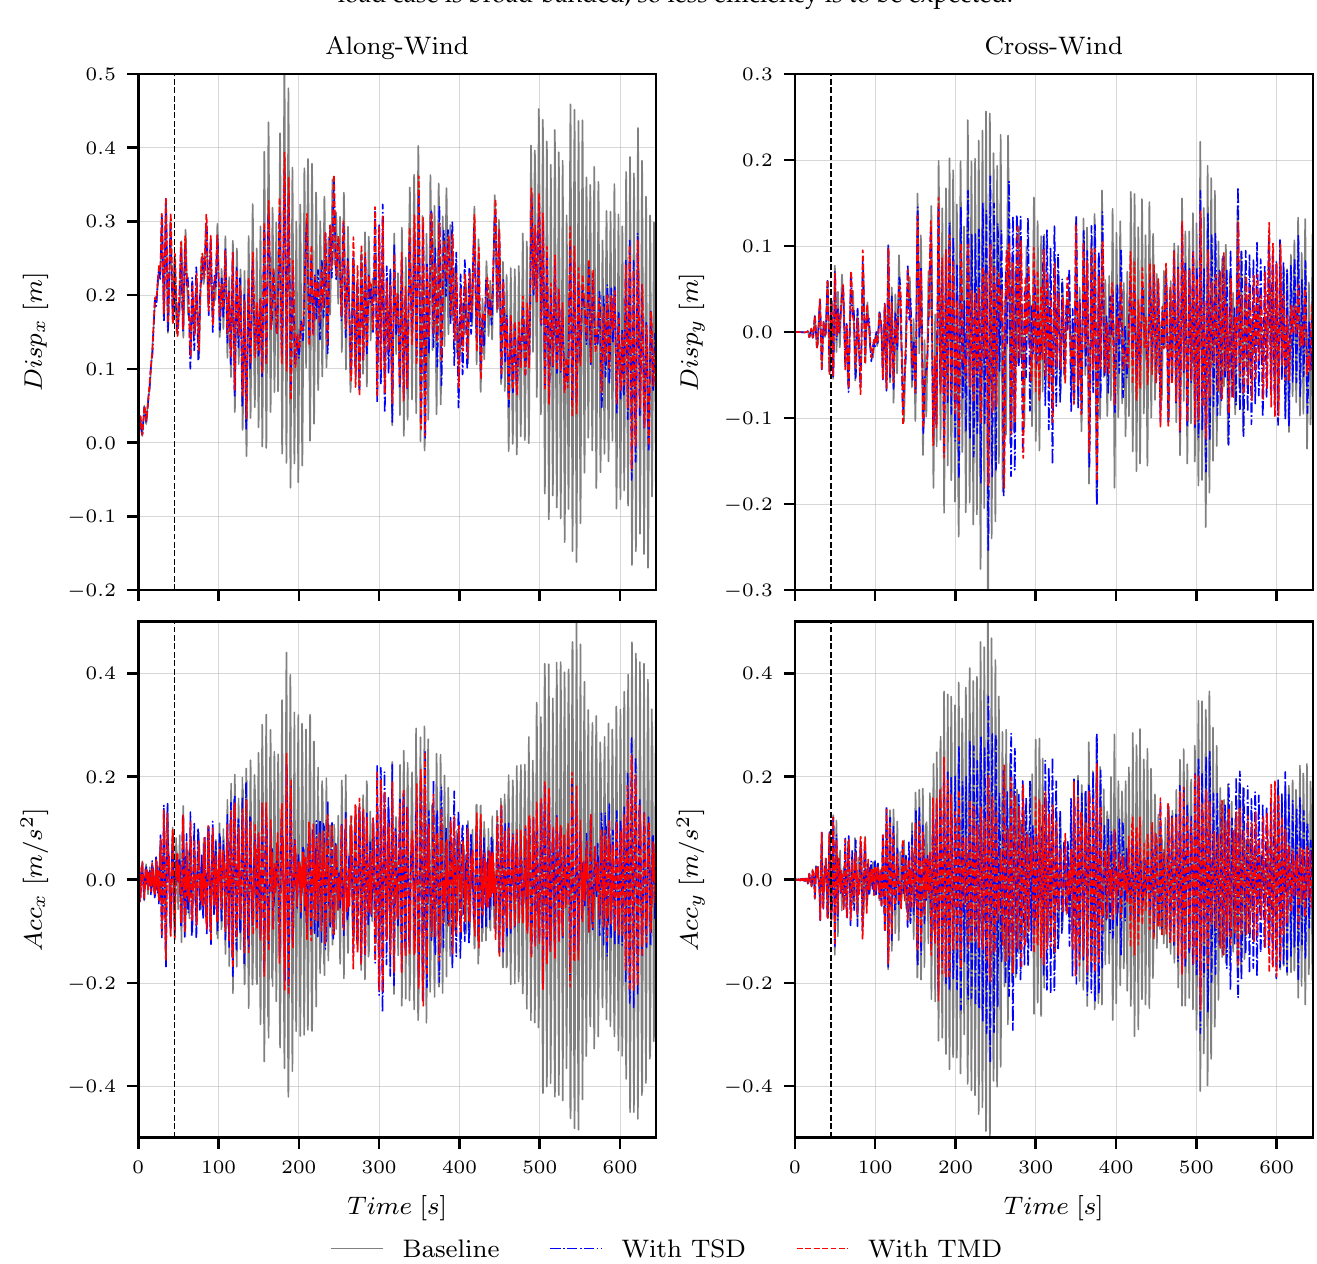
Figure 10. Time series of the kinematics of the top point under turbulent wind loading.